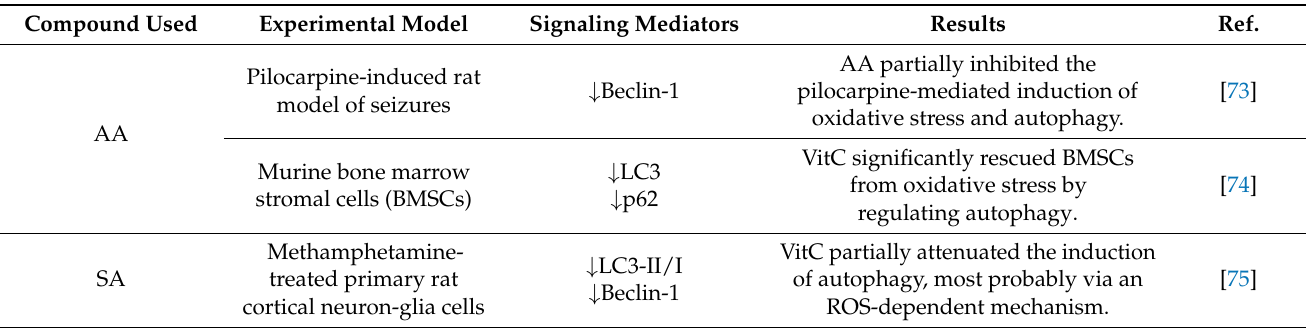
Table 2. Summary of available reports on the modulation of autophagy by vitamin C and its